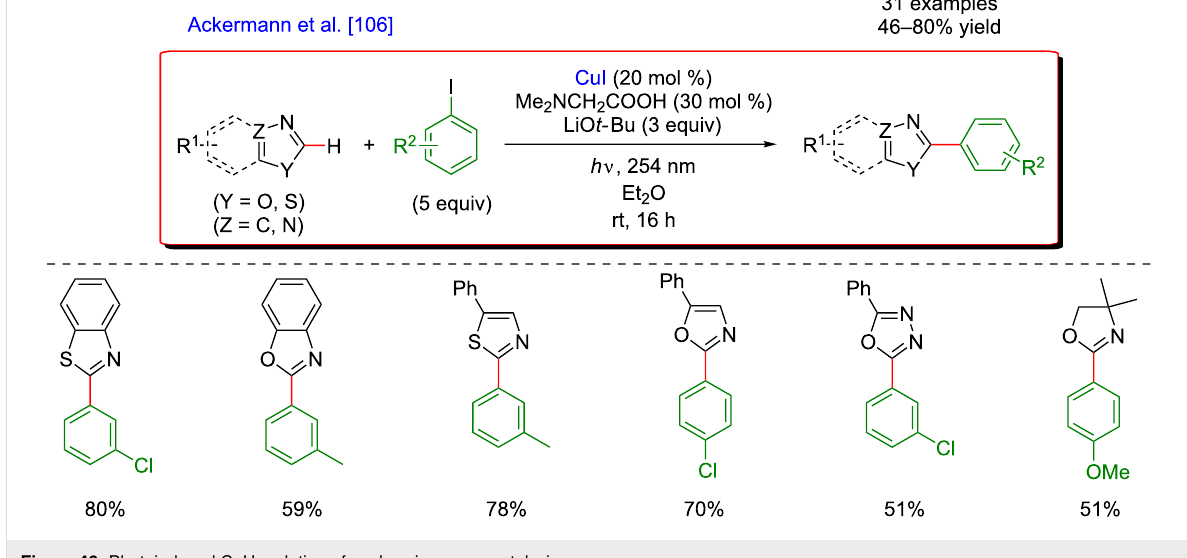
Figure 46: Photoinduced C–H arylation of azoles via copper catalysis.